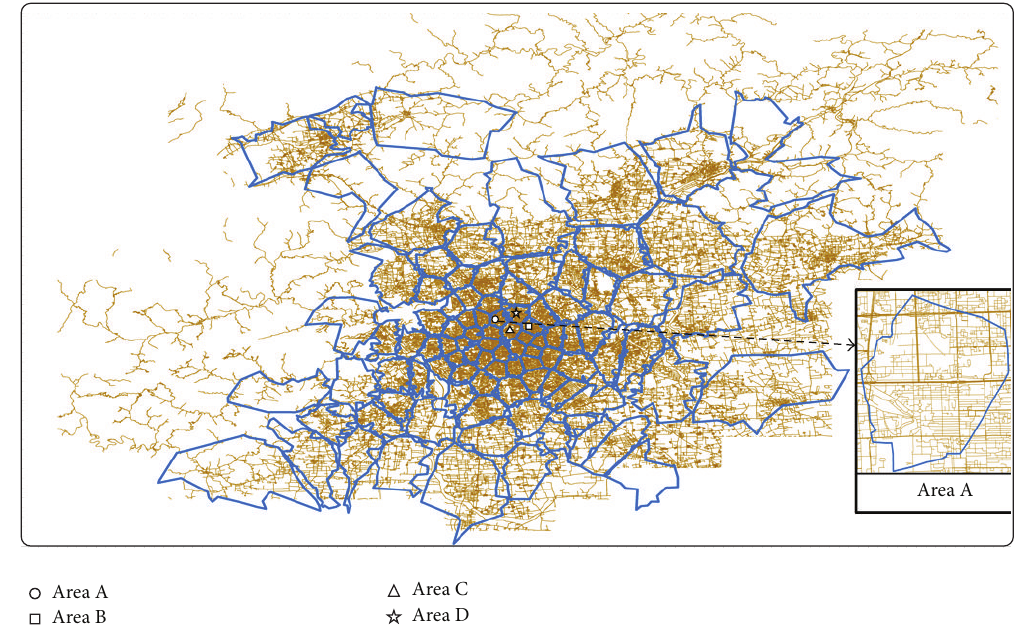
Figure 10: Division results of traffic subarea.